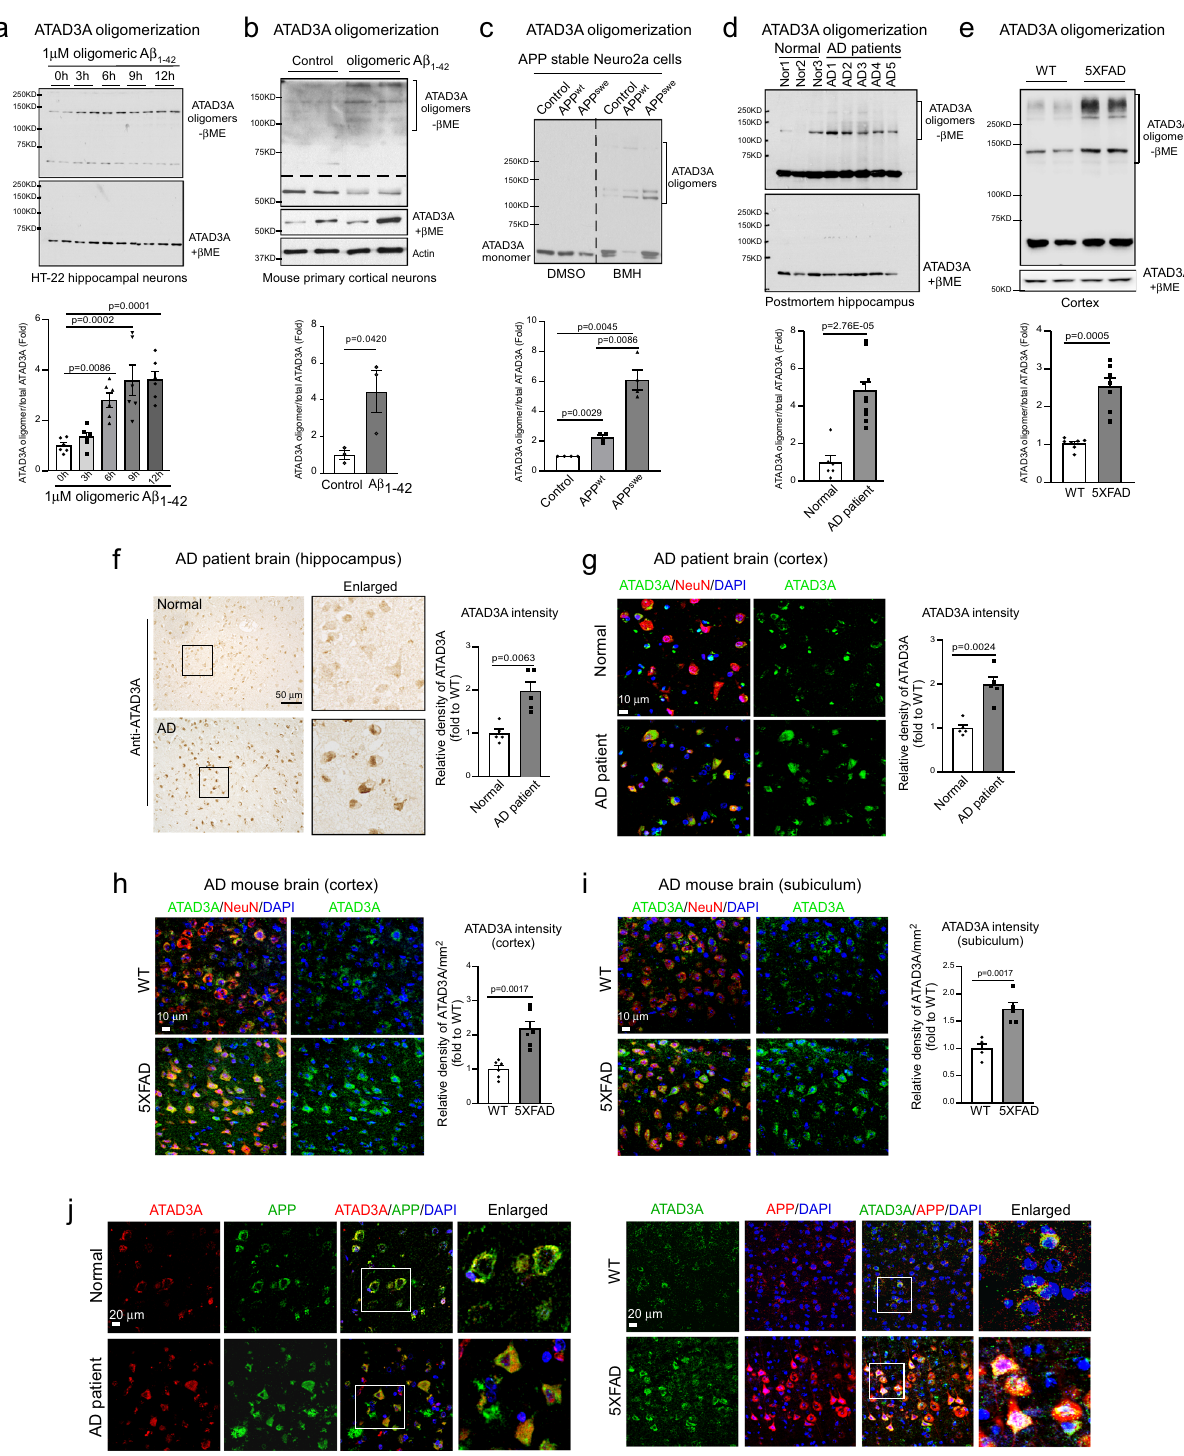
(APP wt )- and APP Swedish mutant (APP swe )-expressing Neuro2a cells in the presence of a chemical cross-linker (bismaleimido- hexane, BMH), with a greater increase observed in the APP swe - expressing cells (Fig. 1c). Consistently, ATAD3A oligomers increased in the total protein lysates from the postmortem hippocampus of AD patients under non-reducing conditions (Fig. 1d). ATAD3A oligomers were also elevated in the cortex, hippocampus, and thalamus of 5XFAD AD mice, but not in other brain regions (Fig. 1e, Supplementary Fig. 2c), consistent